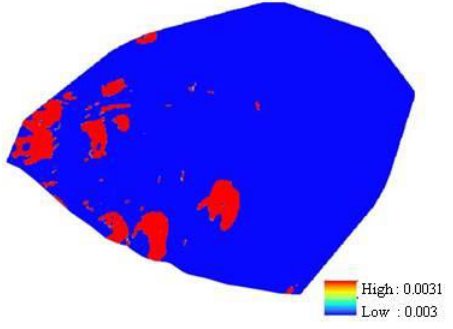
Figure 10. Feasibility image of the sampling